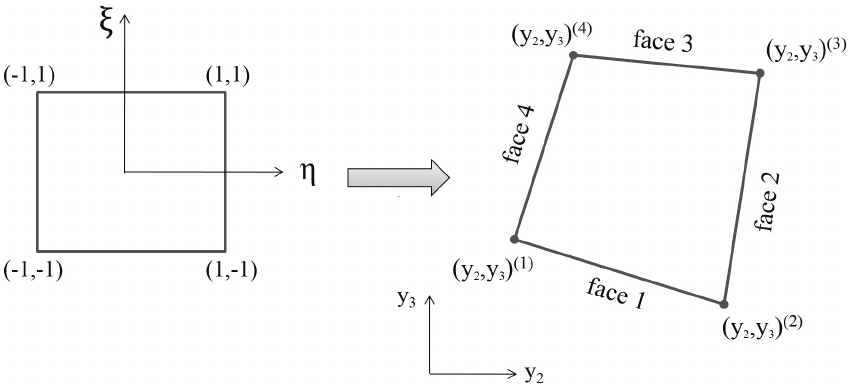
Figure 2. Mapping of the reference square subvolume onto a quadrilateral subvolume of the actual microstructure (after Cavalcante et al. 6